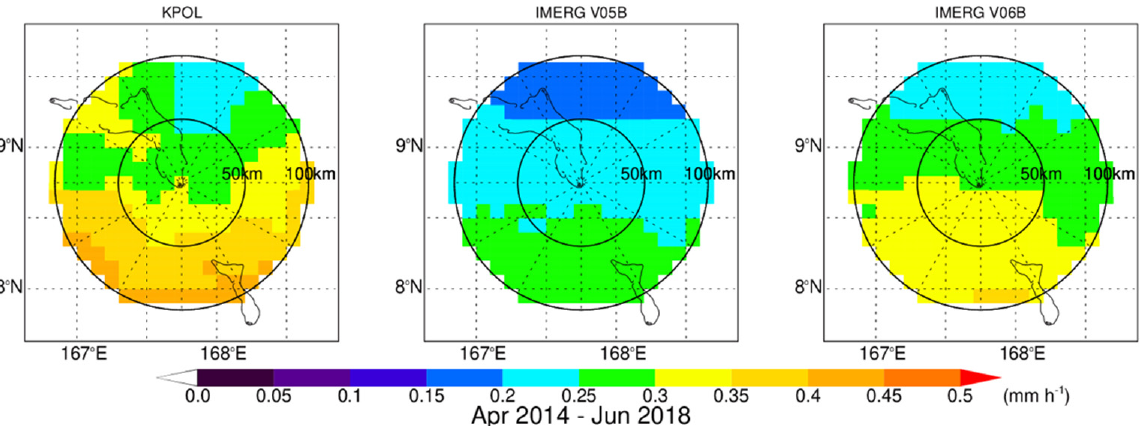
Figure 1. Mean precipitation maps from KPOL, IMERG V05B and V06B over the period of April 2014–June 2018.